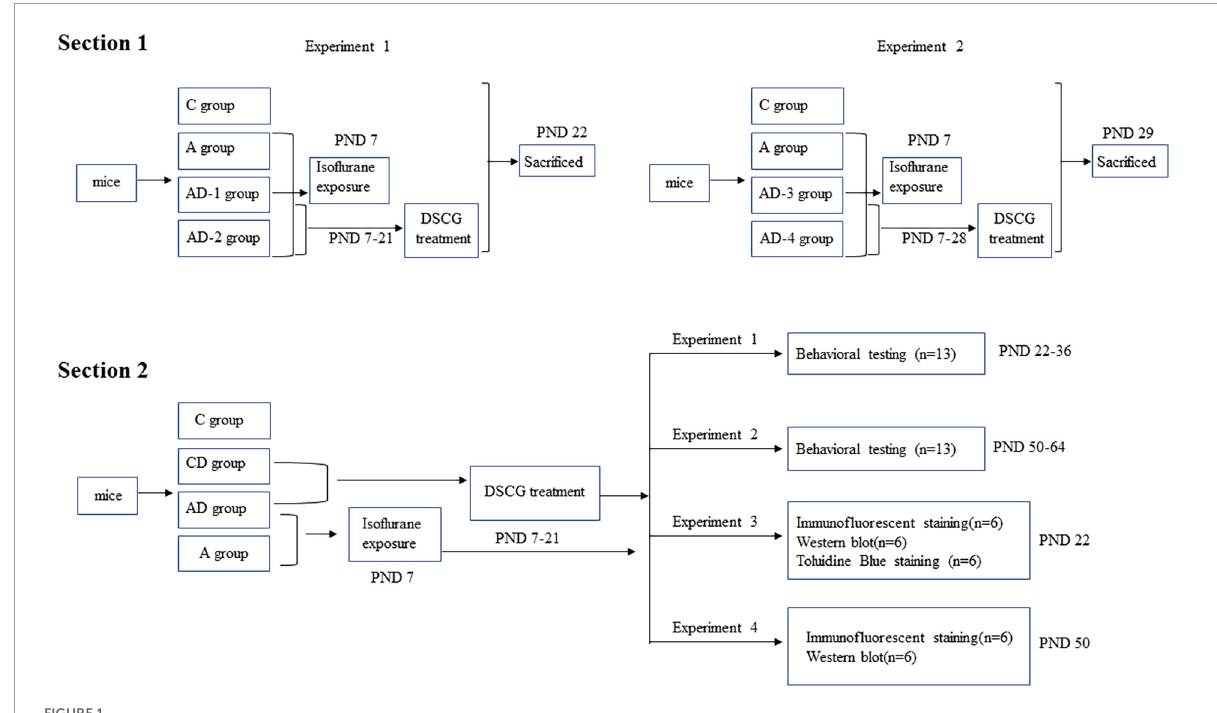
FIGURE1 Diagram of timeline of experimental